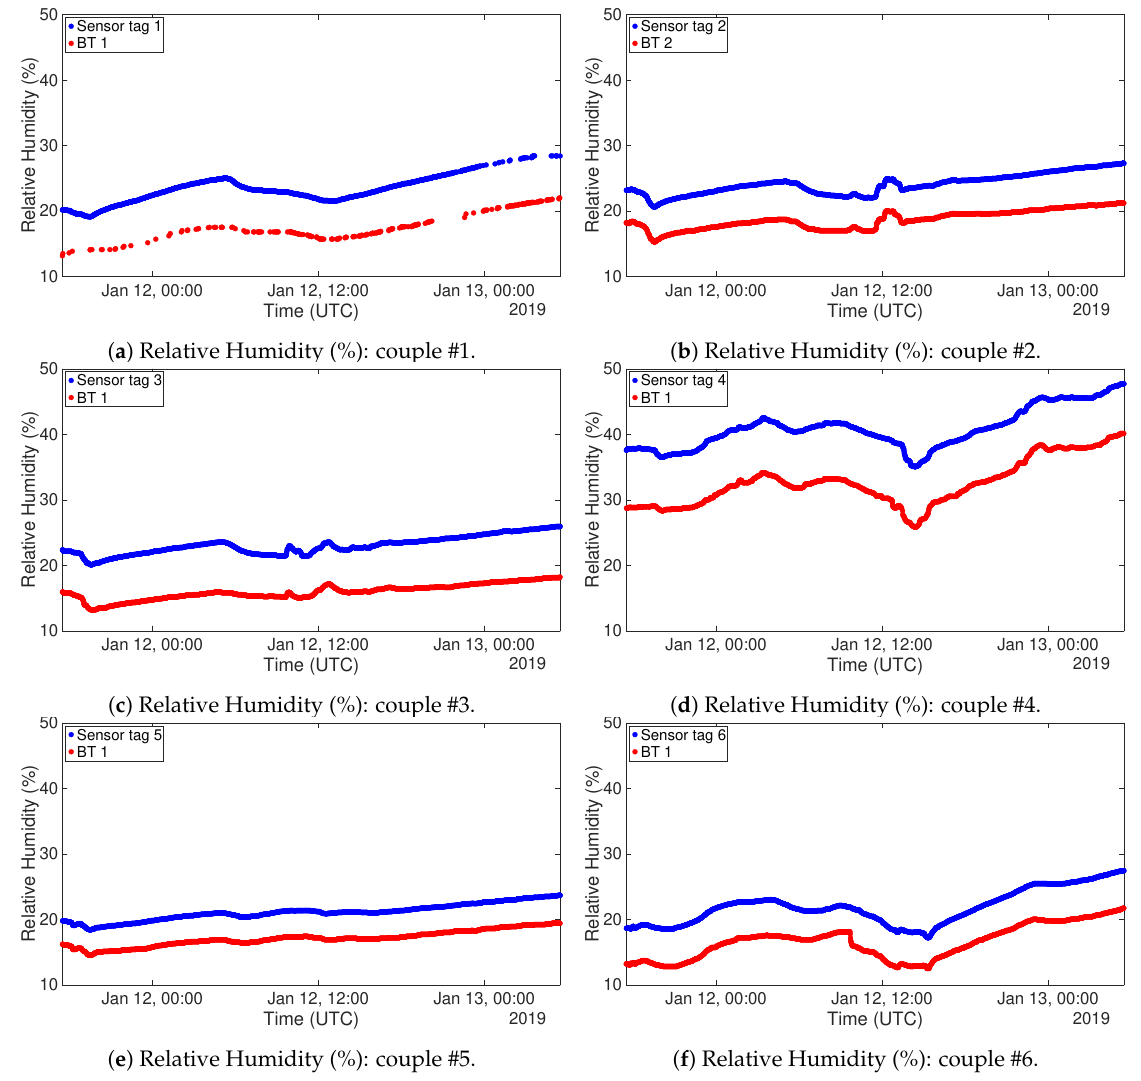
Figure 17. Relative Humidity (%) measurements: RFID (blue) and BT